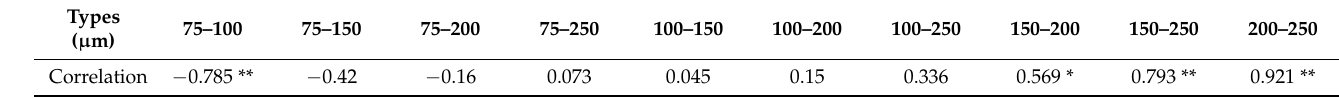
Table 5. Correlation analysis between pollen suspension droplet size and pollen activity. The different intervals of pollen suspension droplet size were divided to be used for correlation analysis with pollen activity.